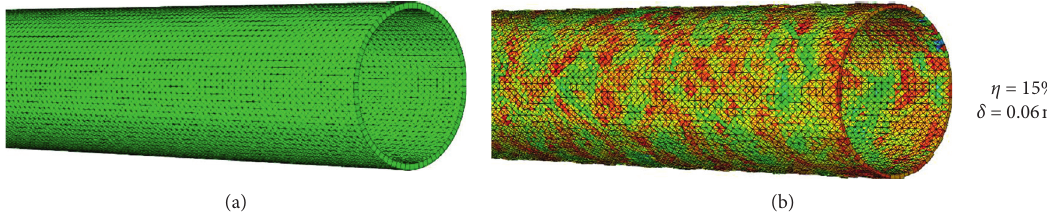
Figure 3: Comparison of surface topologies of an intact and corroded pipe in FE model. (a) Uncorroded. (b) Corroded.